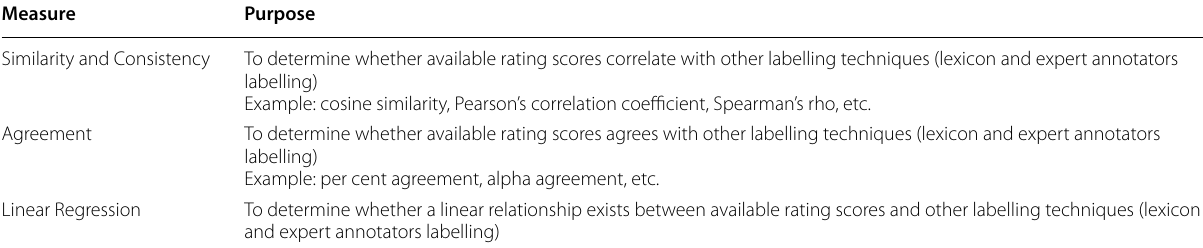
Table 4 Quantitative measures to compute the relationship degree between available rating scores and other labelling Measure Purpose Similarity and